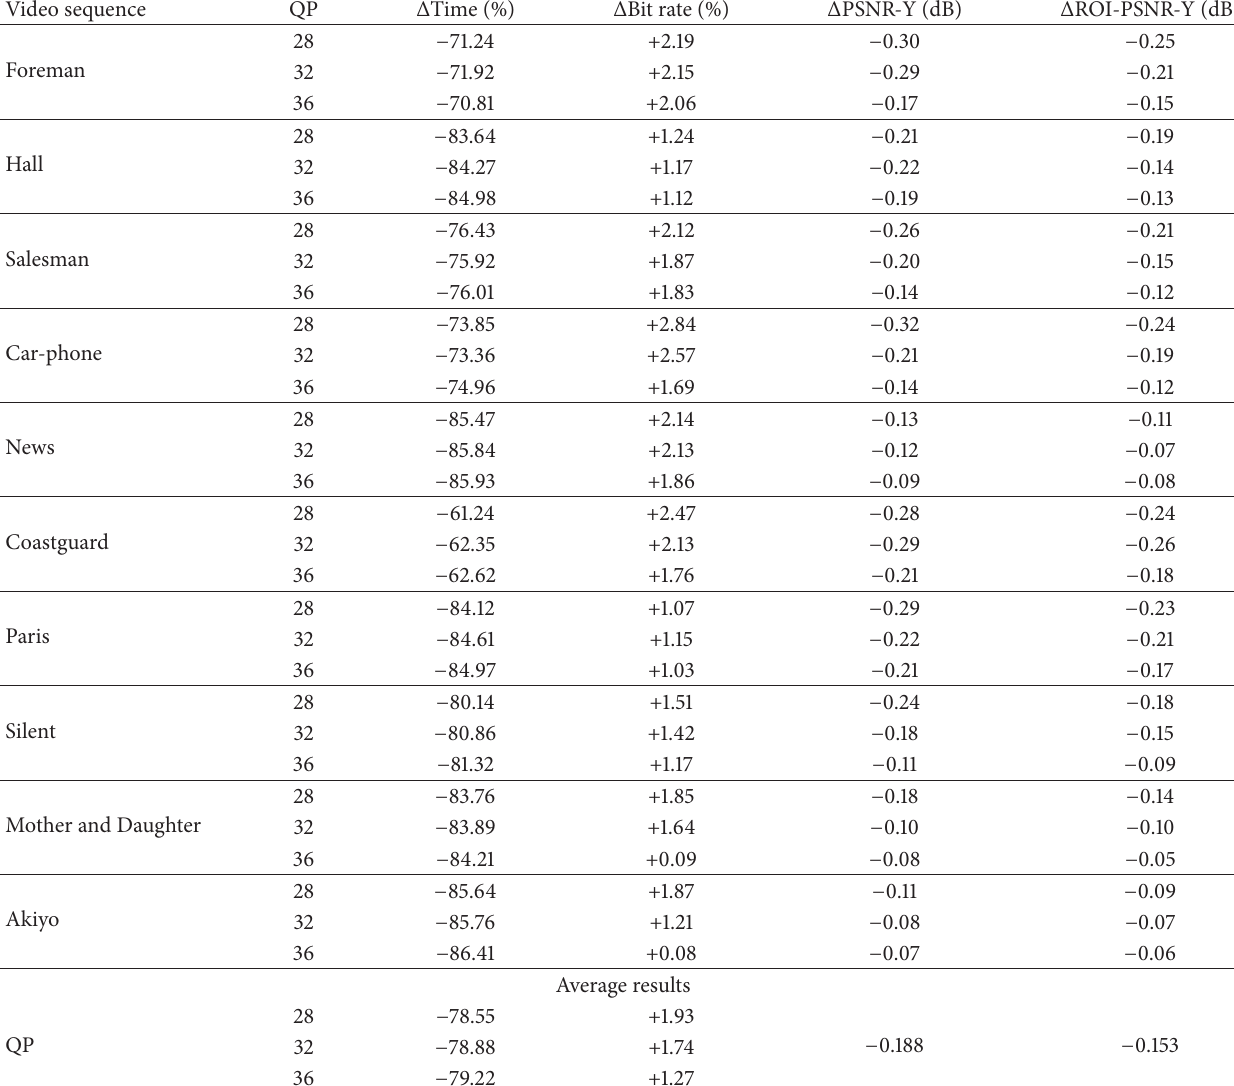
Table 2: Performance of the proposed algorithm compared with H.264/AVC